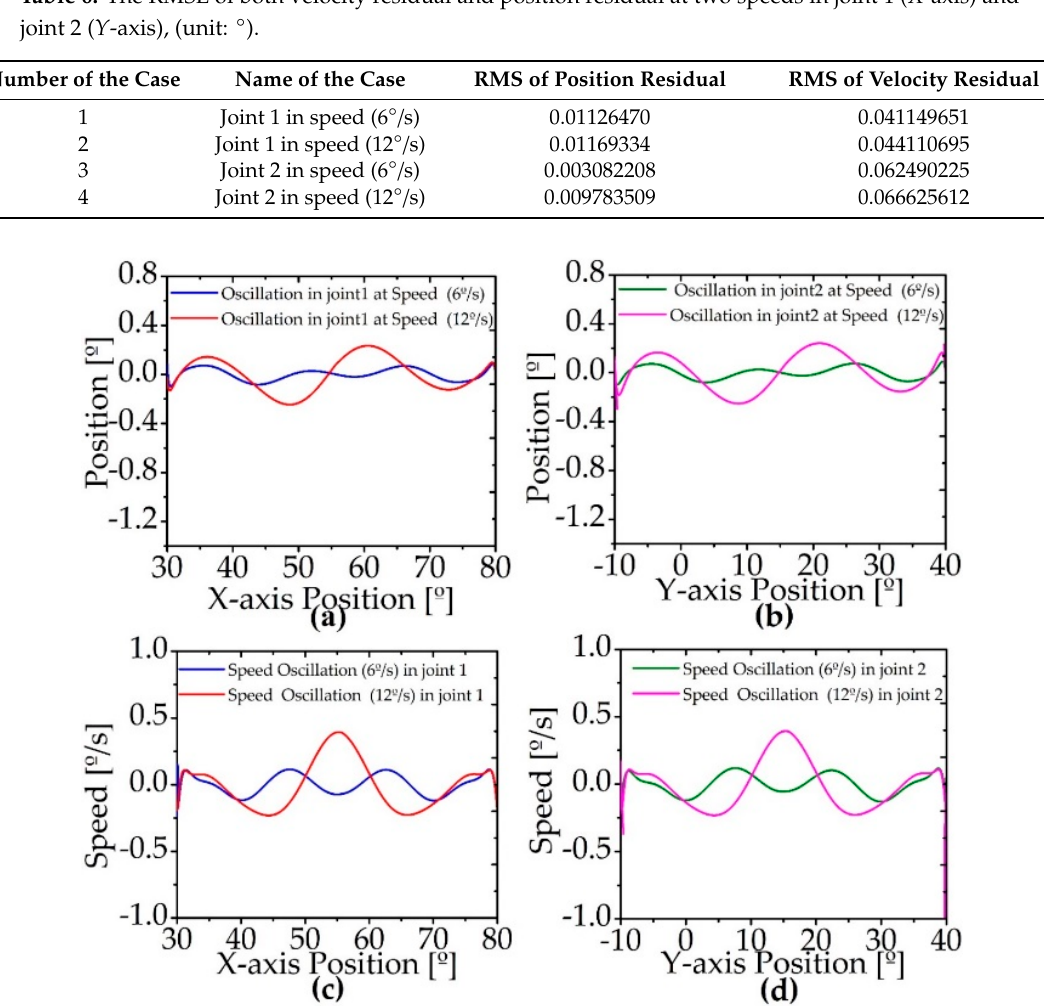
Figure 16. Position oscillations and velocity oscillations at two speeds for both joint 1 and joint 2 in the experiment: ( a ) Position oscillations at 6°/s and 12°/s in joint 1, ( b ) position oscillations at 6°/s and 12°/s in joint 2, ( c ) speed oscillations at 6°/s and 12°/s in joint 1, ( d ) speed oscillations at 6°/s and 12°/s in joint 2. Table 5. The RMSE of both velocity oscillations and position oscillations at two speeds in joint 1 ( X -axis) and joint 2 ( Y -axis), (unit: ° ).